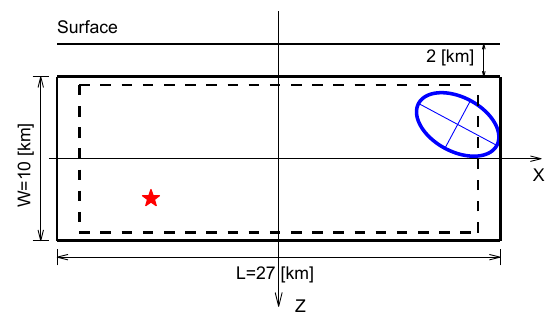
Figure 11. Inferred fault plane configuration with MCMC chain starting from the “symmetric” counterpart